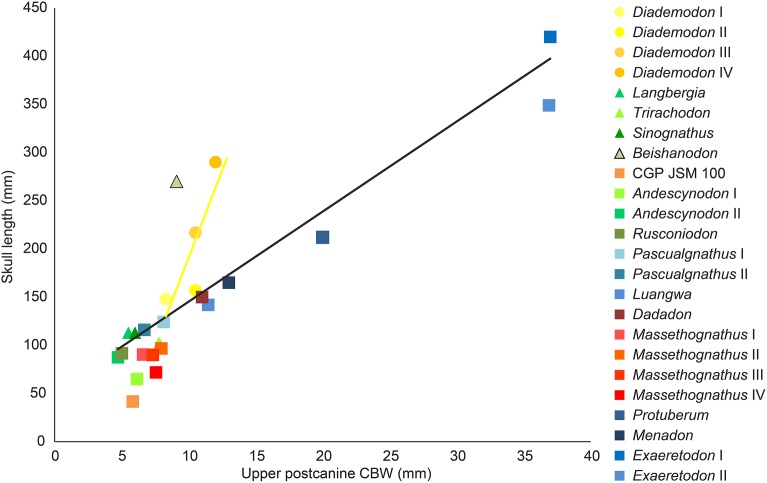
Comparison of skull length and widest upper gomphodont postcanine labiolingual width in gomphodont cynodonts, with linear regression trendlines for gomphodont taxa (in black) and Diademodon (in yellow).Diademodon I, II, and III refer to specimens BSP 1934 VIII 14, MB R1004, and BSP 1934 VIII 19, respectively, Andescynodon I and II to specimens PVL 3836 and PVL 3894-1, Pascualgnathus I and II to specimens PVL 4416 and MLP 65-VI-18-1, and Massetognathus I, II, III, and IV to specimens BP/1/4245, PVL 4729, PVL 4727, and PVL 4613, respectively. Abbreviations: CBW, crown base width.